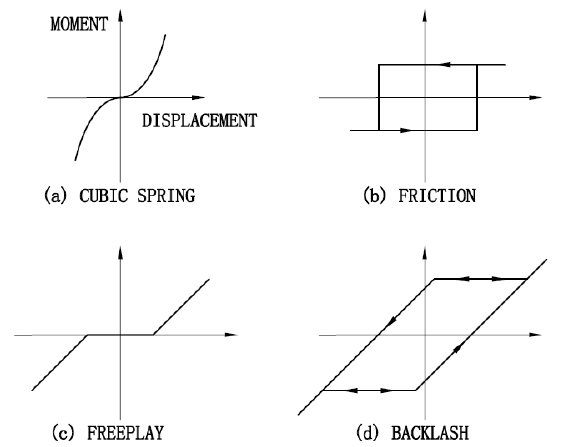
Figure 4. Moment-displacement relationships of four types of structural nonlinear aeroelastic system.